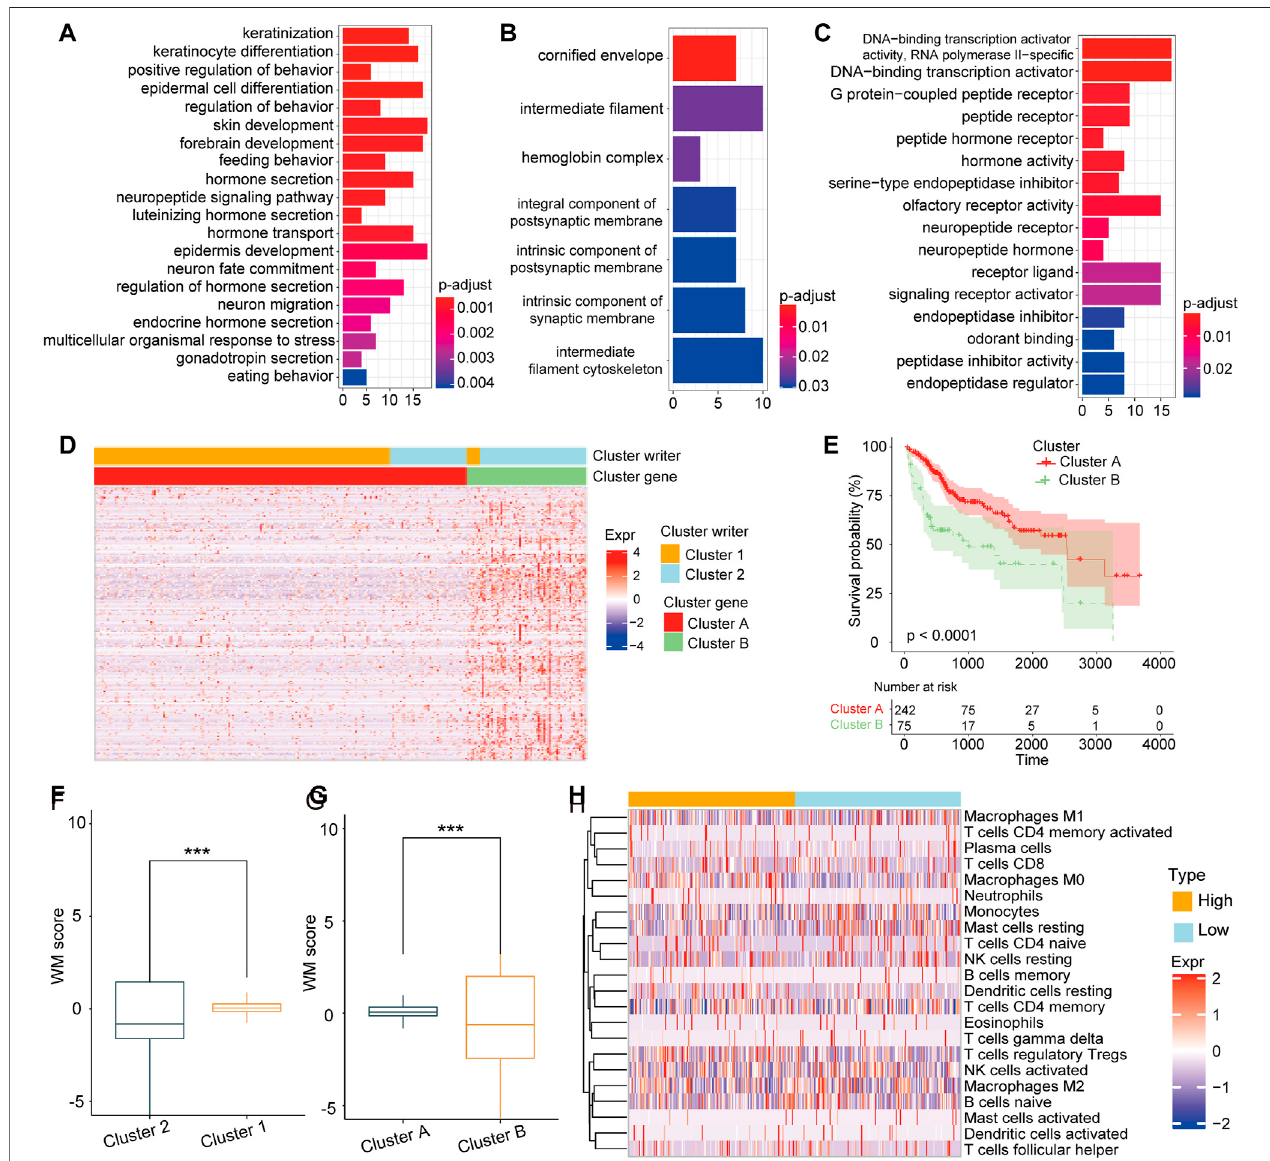
FIGURE 4 | Construction of RNA modi fi cation model (A – C) . GSVA enrichment analysis revealed the DNA transcription signaling pathways. Stress reception signaling pathways (A) and signal transduction activation signaling pathways (B) were correlated with (C) 273 DEGs between cluster 1 and cluster 2 (D) . Unsupervised clustering of the 273 DEGs to identify two genomic subtypes (E ) Survival analysis showing the poor prognosis of patients in cluster A group compared with those in clusterBgroup( p < 0.0001,Log-ranktest) (F) .Thescoreofcluster1washigher thanthatofcluster2. G .ThescoreofclusterAwassigni fi cantlyhigherthanthatof cluster B (H) . The difference of immune cell in fi ltration abundance between WM-Score groups calculated by the CIBERSORT algorithm.